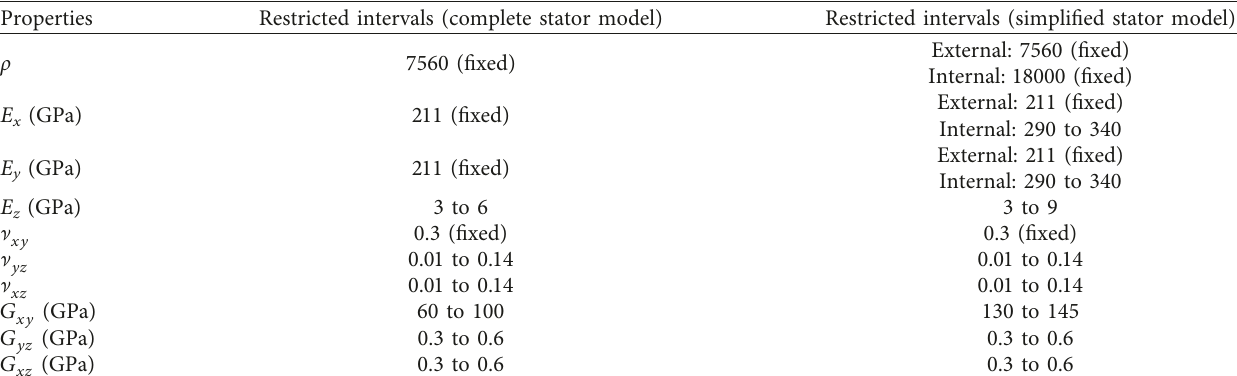
Figure 17: Modal shapes of the winding in the complete model (300 to 900Hz band): (a) ω N : 381.9 Hz; (b) ω N : 422.4Hz; (c) ω N : 457.5Hz; (d) ω N : 605.0Hz; (e) ω N : 620.1 Hz; (f) ω N : 658.2Hz; (g) ω N : 662.4Hz; (h) ω N : 752.0Hz; (i) ω N : 851.6 Hz. Table 3: Restriction of the interval of the